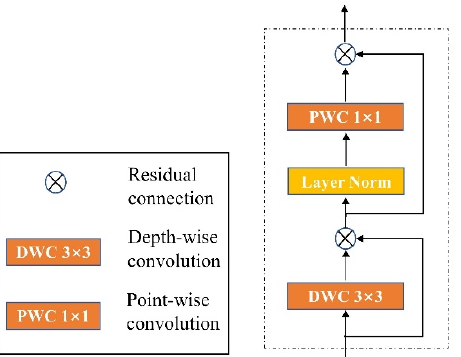
Figure 3. Comparison of original Patch embedding form ViT and improved Overlapping patch em- bedding.